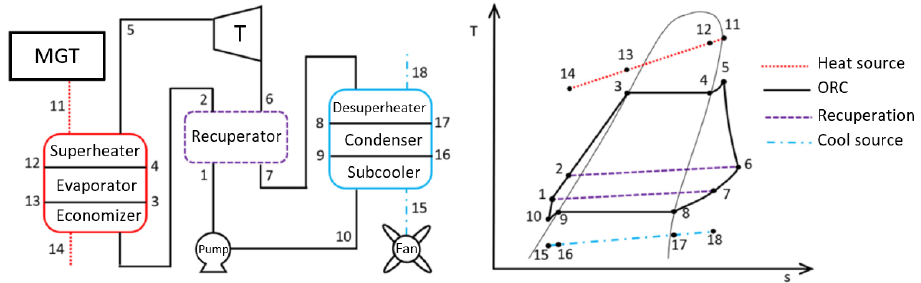
Figure 17. Plant scheme of a generic ORC and temperature vs entropy diagram [120].